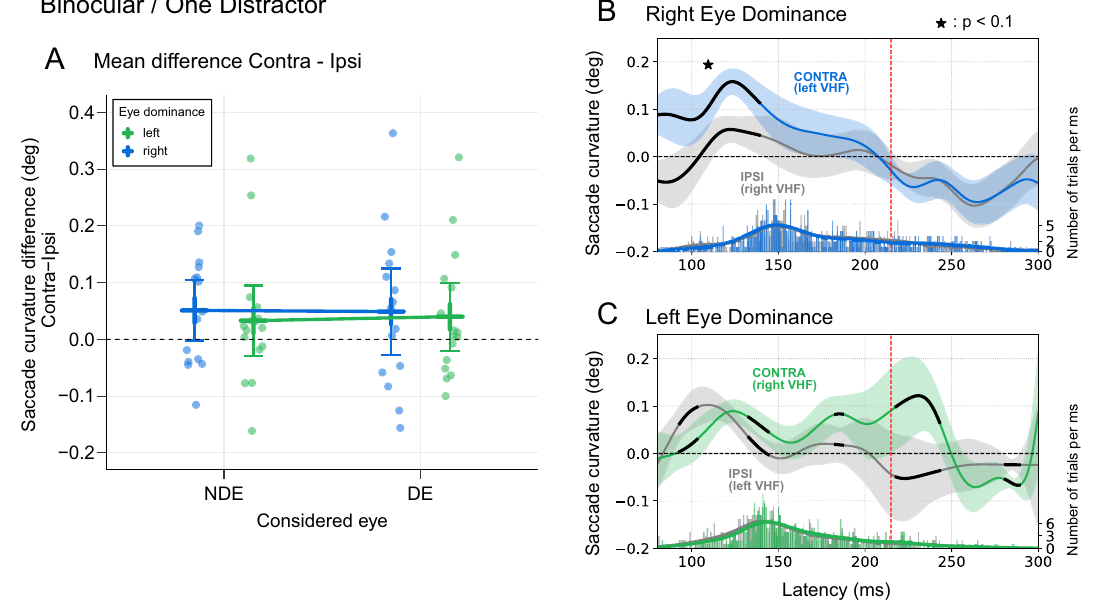
Figure 4. Saccade trajectory curvature in Binocular / One Distractor condition. ( A ) For each participant and for saccades initiated before the toward/away switch latency (215 ms, red vertical line on Fig. 3 and on panels B & C on the right), the difference between curvature values for a distractor in the contralateral hemifield with respect to the DE and for a distractor in the ipsilateral hemifield was plotted as a function of the considered eye. Positive values correspond to a larger curvature for a contralateral distractor. Error bars show 95% confidence intervals. The linear model approach shows a statistically significant difference from zero (p < 0.05) for the whole population. See text for further details. ( B ) Saccade curvature as a function of saccade latency in right DE participants. Blue and grey curves correspond to curvature values for trials with a distractor in the contralateral or ipsilateral hemifield, respectively. Positive values correspond to a curvature toward the distractor. Data are smoothed with a Gaussian kernel, with the black line indicating a cluster of time points where a weighted within-subjects t-test resulted in p < 0.05 between the two hemifields. Asterisk indicates that this cluster survives at the multiple comparisons control at p < 0.1. The shaded areas are 95% within-subjects confidence intervals. The bottom histogram displays the number of trials per 1 ms bin for both conditions (right axis, lines correspond to smoothing with the same kernel as above). ( C ) Saccade curvature as a function of saccade latency in left DE participants. Green and grey curves correspond to curvature values for trials with a distractor in the contralateral or ipsilateral hemifield, respectively. Black line segments correspond to clusters with significant t tests between the two hemifields for successive time points, but none of these clusters survive at the multiple comparisons control and thus should be considered as non-significant. Same organization as for panel